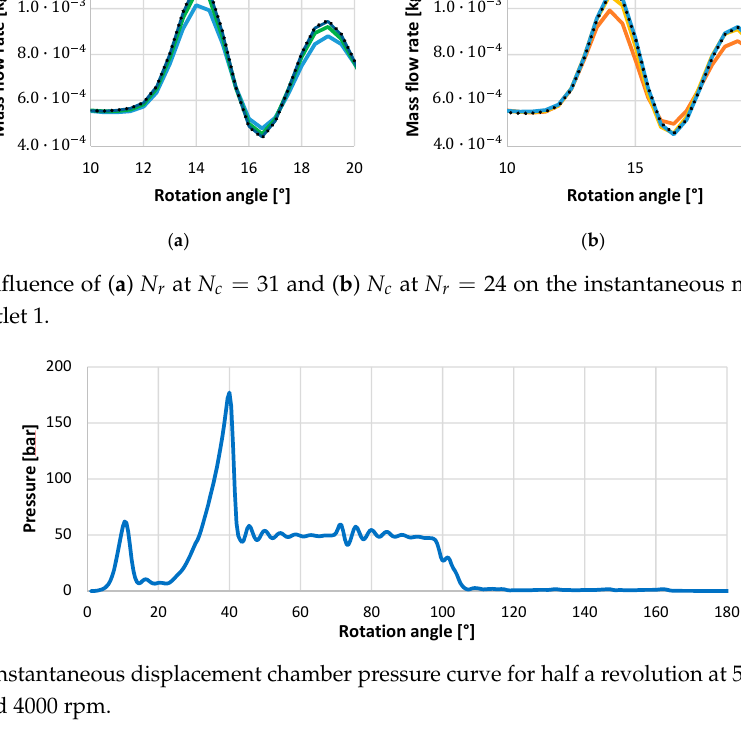
Figure 10. Instantaneous displacement chamber pressure curve for half a revolution at 50-bar delivery pressure and 4000 rpm.